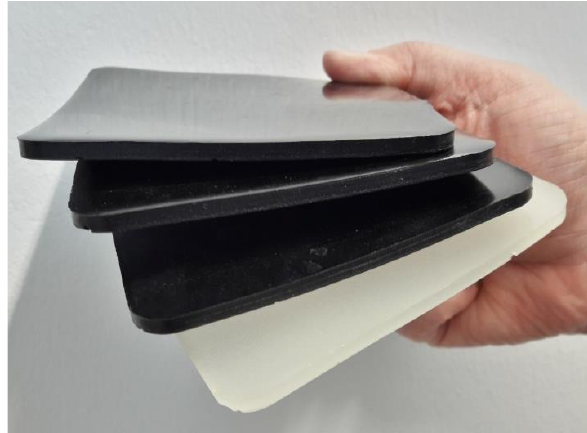
Figure 2. Biopolyurethane samples. Mass proportions (%) of Sphagnum moss (from top to bottom): 16, 10, 4, and 0 %.